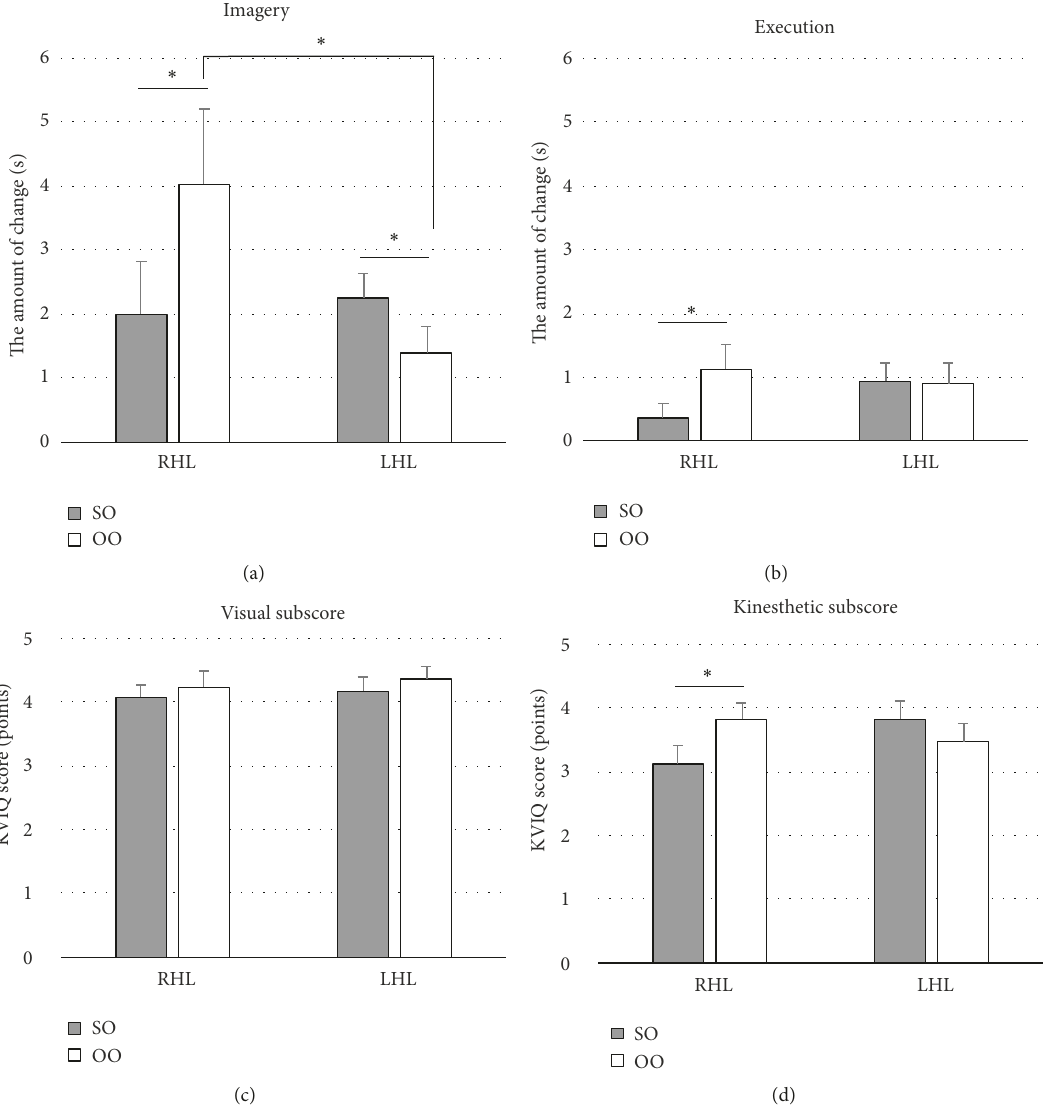
Figure 3: (a) The amount of change in imagery times. In the RHL subgroup, the amount of change in imagery times was significantly larger in the other-observation (OO) condition than in the self-observation (SO) condition. In the LHL subgroup, the amount of change in imagery times was significantly larger in the SO condition than in the OO condition. In the comparison between subgroups, the amount of change in imagery in the OO condition was significantly larger in the RHL subgroup than in the LHL subgroup. The error bars represent the standard error. ∗ Significantdifference(P < 0.05).(b) Theamountof changein executiontimes. In the RHL subgroup,the amountof changein execution timeswassignificantlylargerintheOOconditionthanintheSOcondition.Theerrorbarsrepresentthestandarderror. ∗ Significantdifference (P < 0.05). (c) The kinesthetic and visual imagery questionnaire (KVIQ) visual subscore. The error bars represent the standard error. (d) The KVIQ kinesthetic subscore. In the RHL subgroup, the KVIQ kinesthetic subscore was significantly larger in the OO condition than in the SO condition. The error bars represent the standard error. ∗ Significant difference (P <